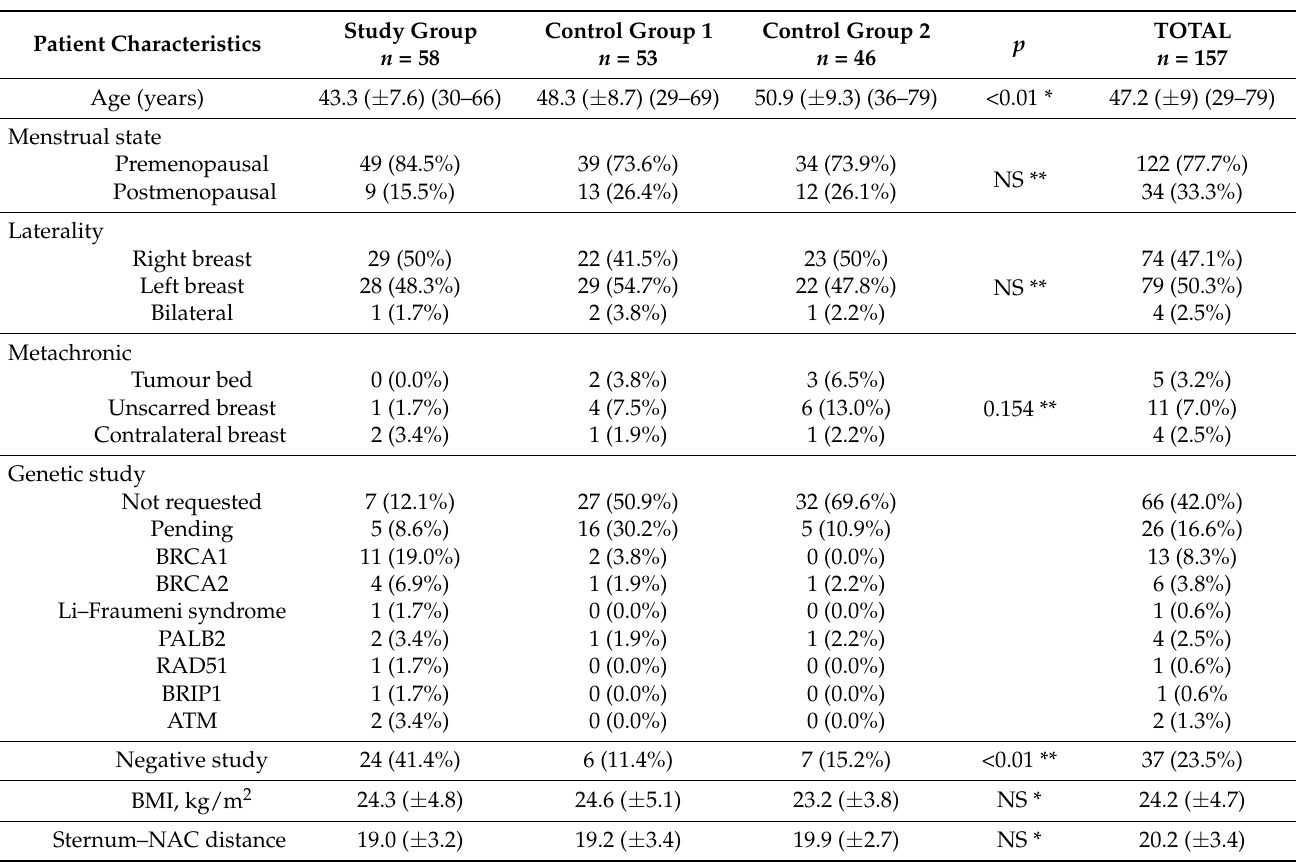
Table 1. Patients’ clinical characteristics.